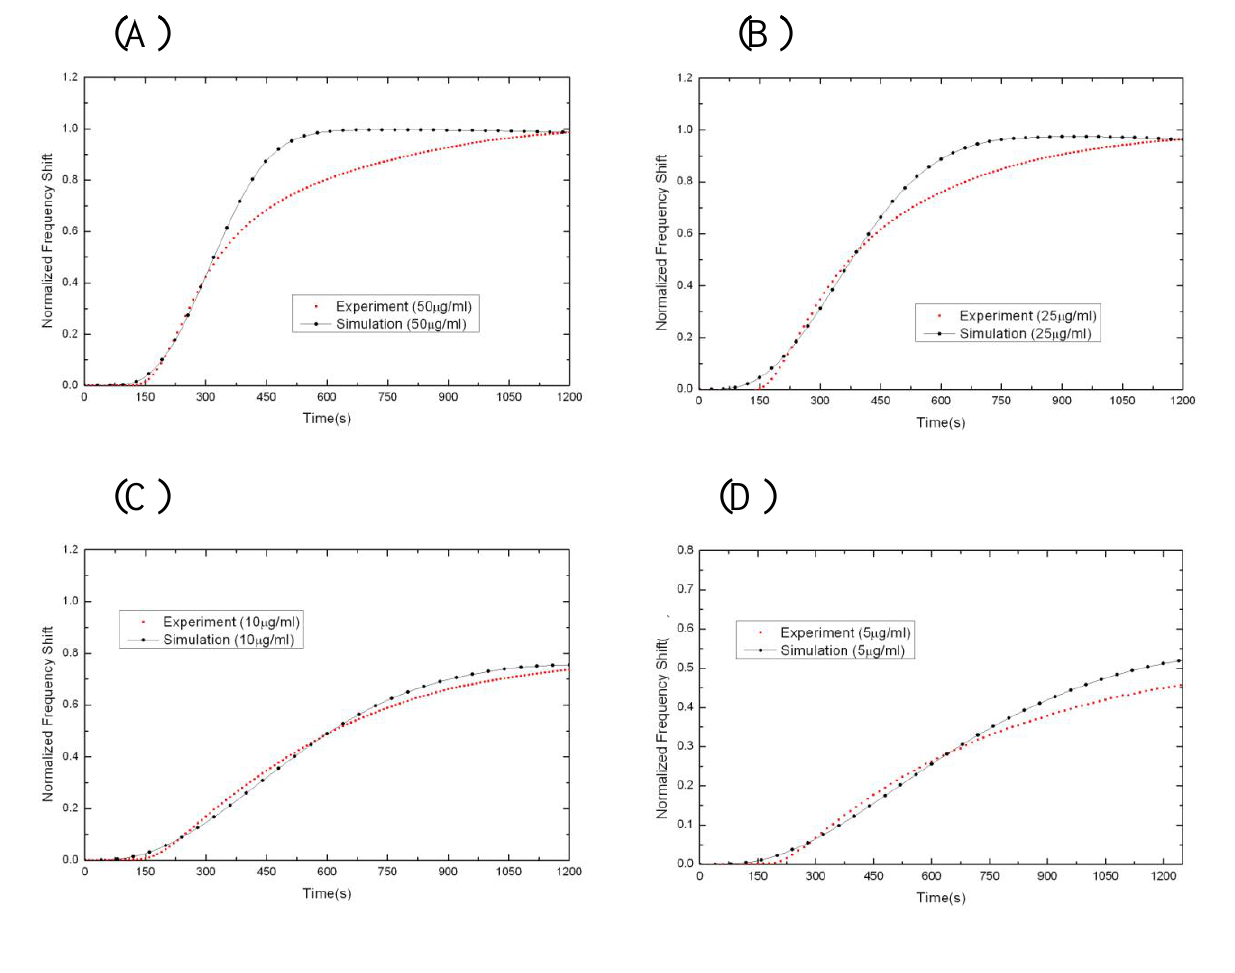
Figure 6. The normalized experimental and simulated binding reaction curves for the 800 μL supplement volume. Here the concentrations of the Anti-Human IgG1 solution